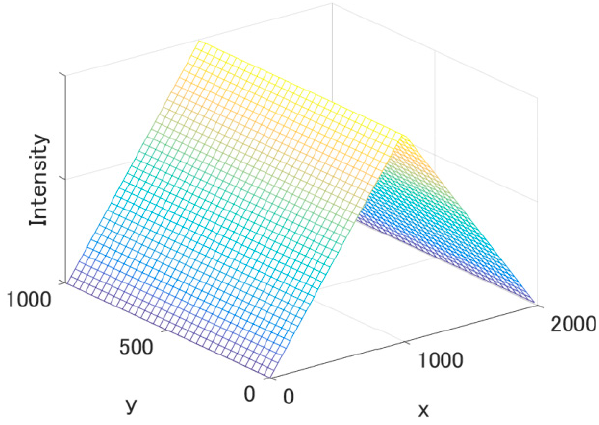
Figure 2. Schematic diagram of the weighting function for convolving ASTER data to be spatially compatible to MODIS aggregated 1 km-resolution data. The units of the x and y axes are meters.